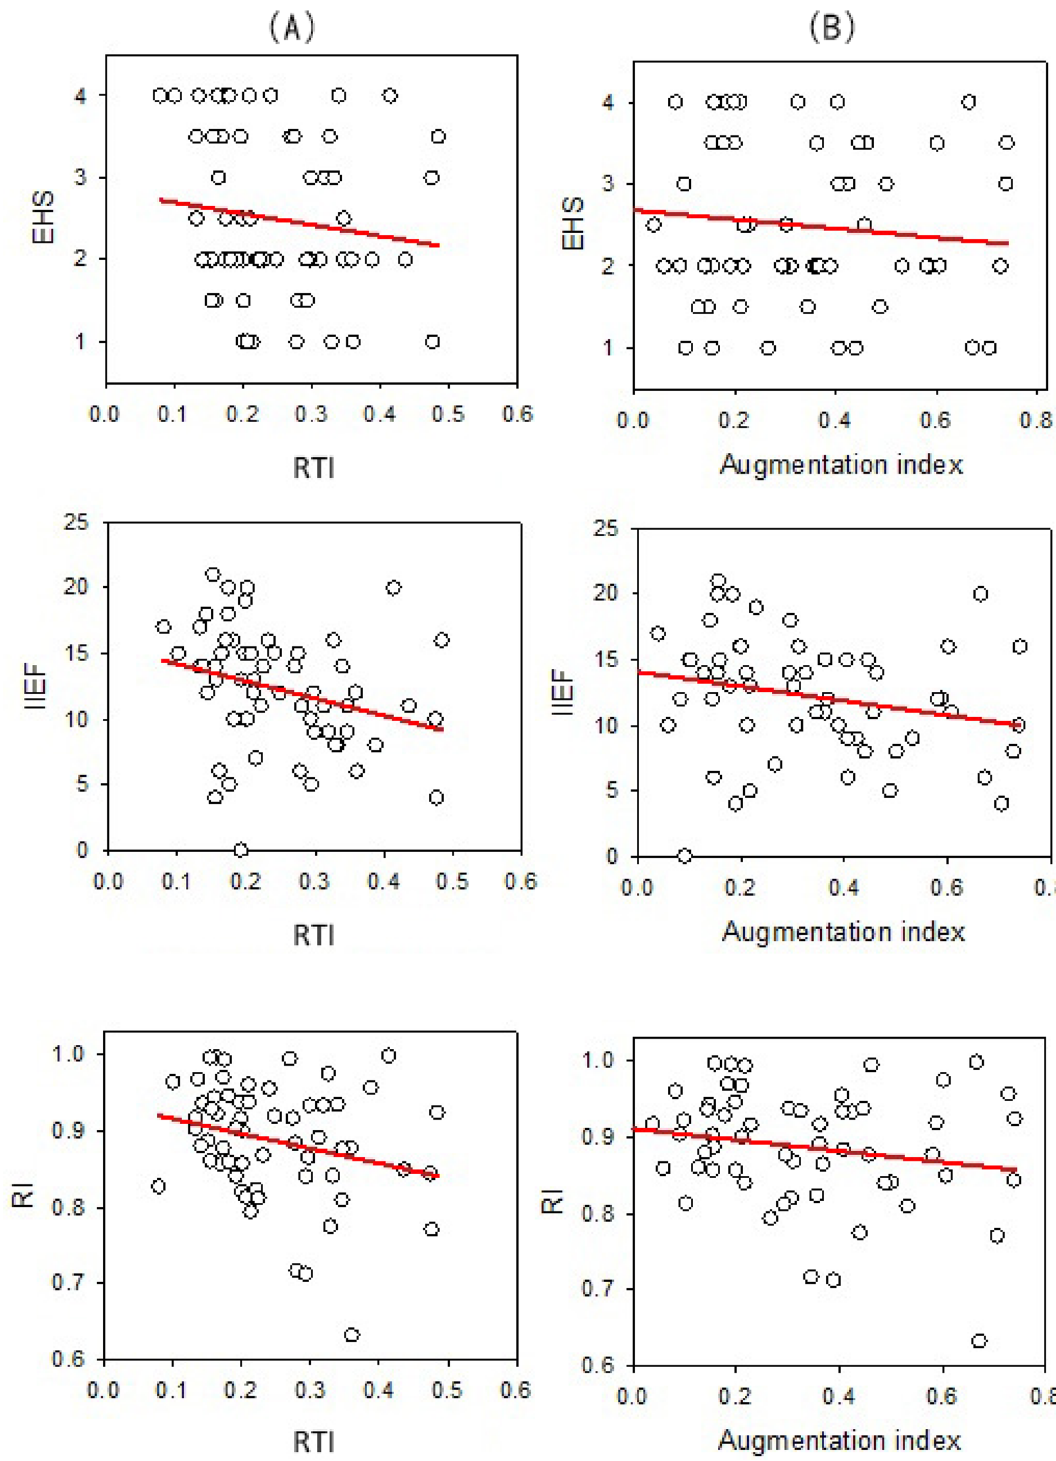
Figure 2. The waveform series and sexual function. A: Negative trends among RTI, EHS, IIEF, and RI; B: negative trends among AI, EHS, IIEF, and